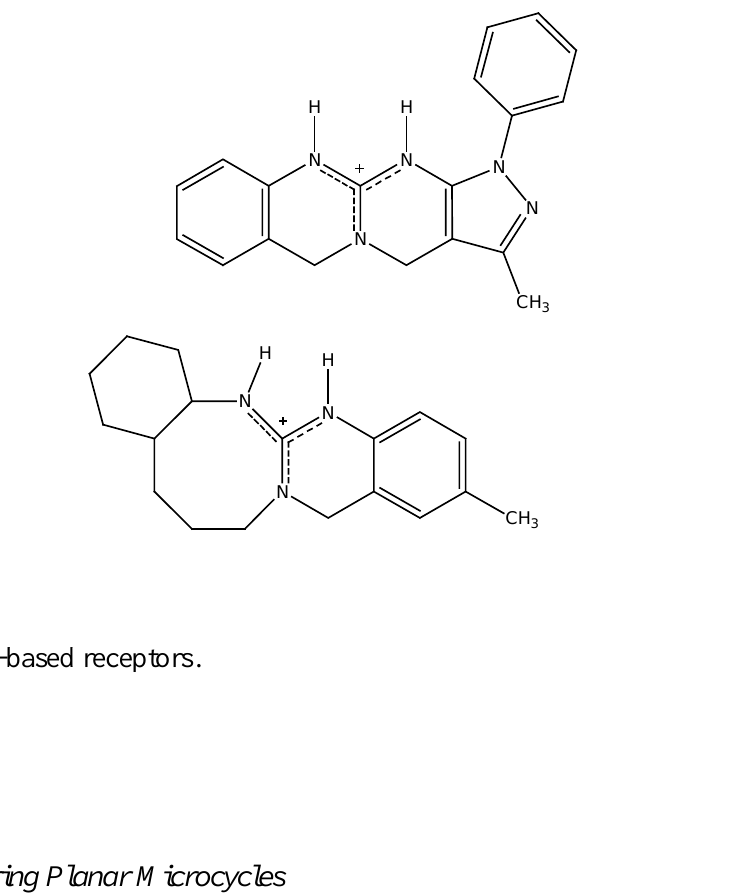
Figure 3. A Rigid tripodal ligand ((3,5-bis(aminomethyl)-2,4,6-triethylphenyl)methanamine).